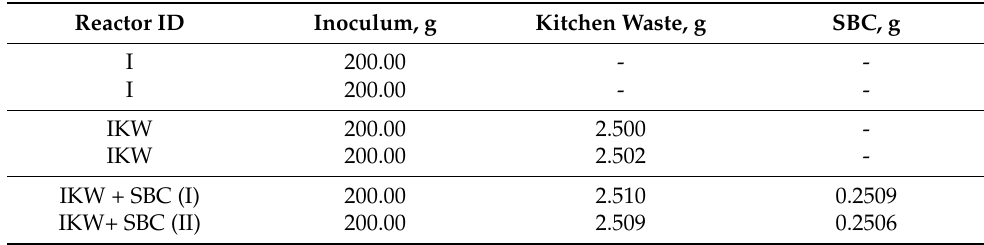
Table 1. Masses of individual components in methane fermentation reactors (I—inoculum, IKW— inoculum with kitchen waste, SBC—sulfur–biochar